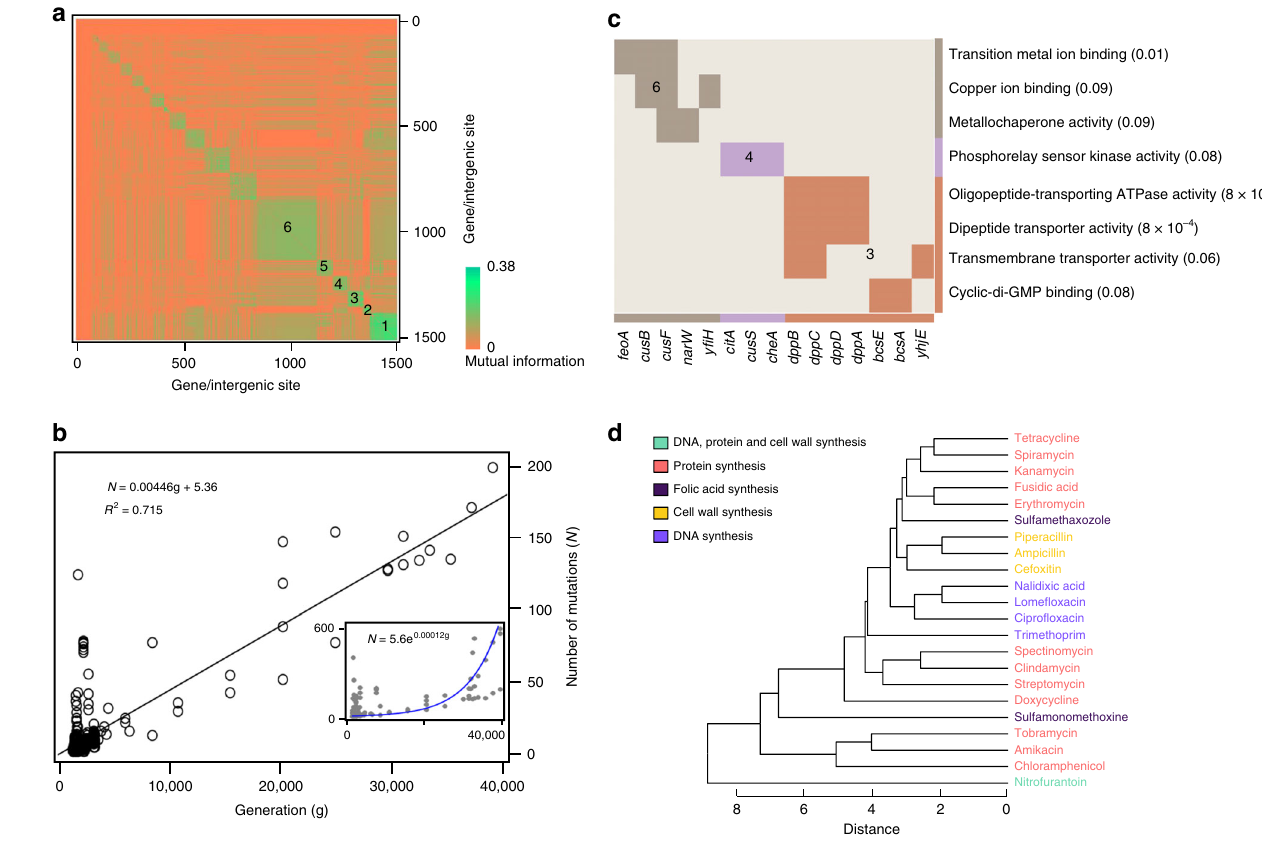
Fig. 3 Mutation pro fi le analysis for co-occurrence and functional relationships. a Spectral clustering of mutations occurring in two or more conditions. Squares along the diagonal represent clusters of genome sites which are highly correlated with respect to mutation pro fi les. The average pairwise mutual information in each cluster decreases from cluster 1 to cluster 6. Heatmap based on mutual information. b The enriched molecular function GO terms and corresponding genes. In each cluster the genes mapped to the same GO terms are together (clusters have different colors and indices). The numbers following each GO term are p values calculated by DAVID ( p value threshold is 0.1). The color bar at the bottom and right indicates the membership of the GO terms/genes among the three clusters. Only clusters with enriched GO terms are shown. c The number of mutations as a function of generations elapsed, with hypermutator strains excluded. Inset shows patterns when hypermutators are included with fi tted exponential curve in the inner plot being N = 5.6e 0.00012g . The R 2 for linear and exponential fi tting is 0.72 and 0.35, respectively. d A dendrogram illustrating the clusters of antibiotics generated by hierarchical clustering. The legend describes the action mechanism of each category of antibiotics. When computing the pairwise distance, the Euclidean distance between mutation pro fi les was